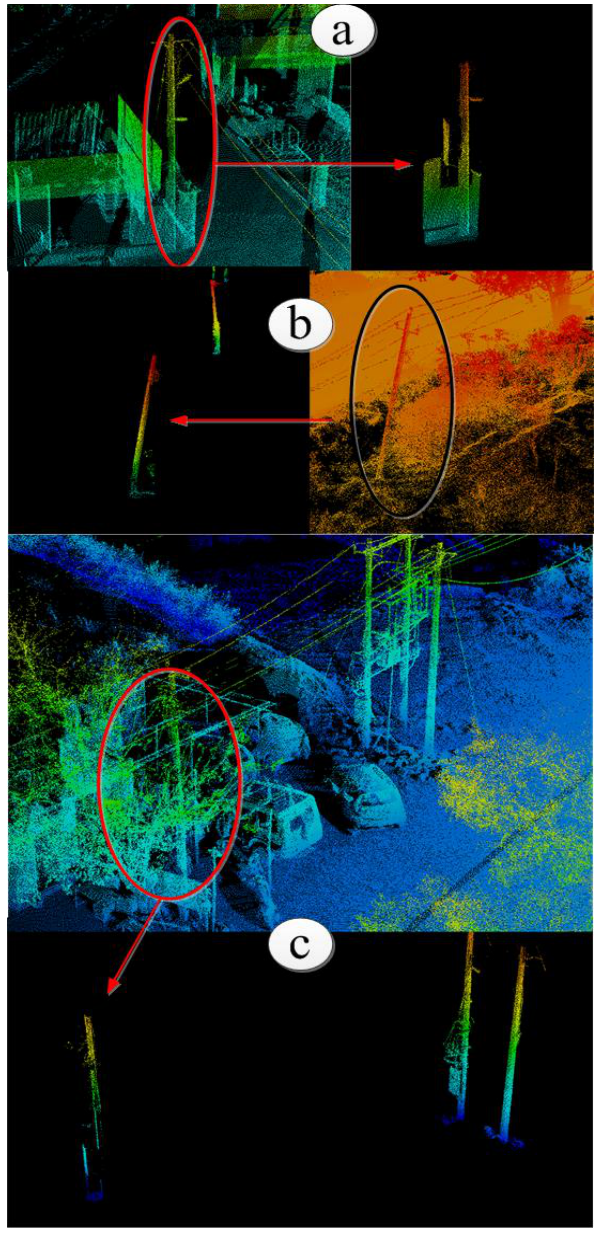
Figure 5. View of detected (a) Utility pole attached with boundary wall (b) Tilted utility pole (c) Occluded utility pole by tree